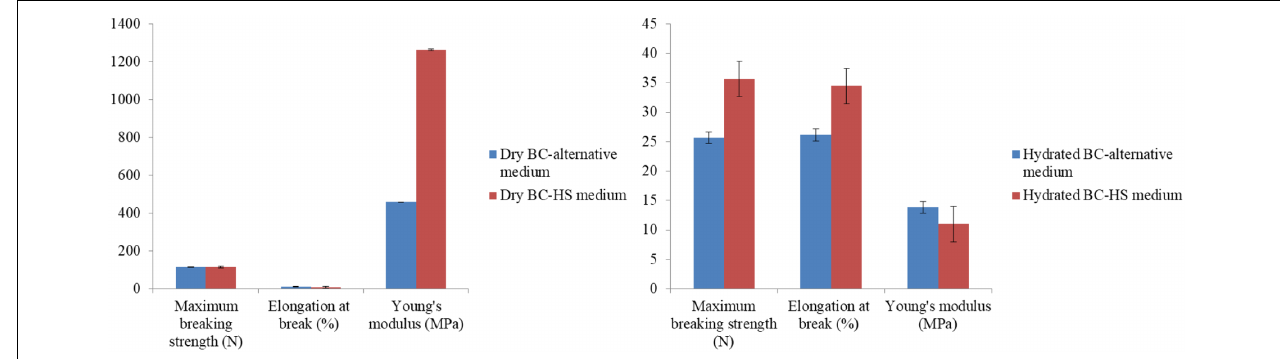
FIGURE 5 | Mechanical properties of dry and hydrated BC pellicles produced with Hestrin–Schramm (HS) medium (2% glucose, 0.5% yeast extract, 0.5% peptone, 0.27% Na 2 HPO 4 , and 1.5% citric acid) and produced with the alternative medium formulated with 1.5% glucose, 2.5% CSL, 0.27% Na 2 HPO 4 , and 1.5% citric acid.